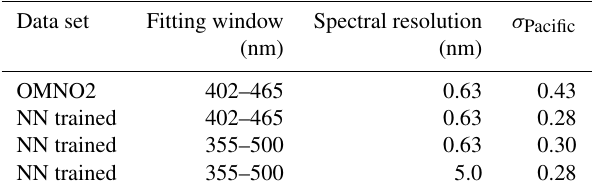
Table 4. Standard deviation for NO 2 SCD normalized by the strato- spheric air mass factor of the Pacific region shown in Fig. 9 ( σ Pacific ) over 40780 points on 28 January 2005 (day not used in training) in units of 10 15 molecules per square